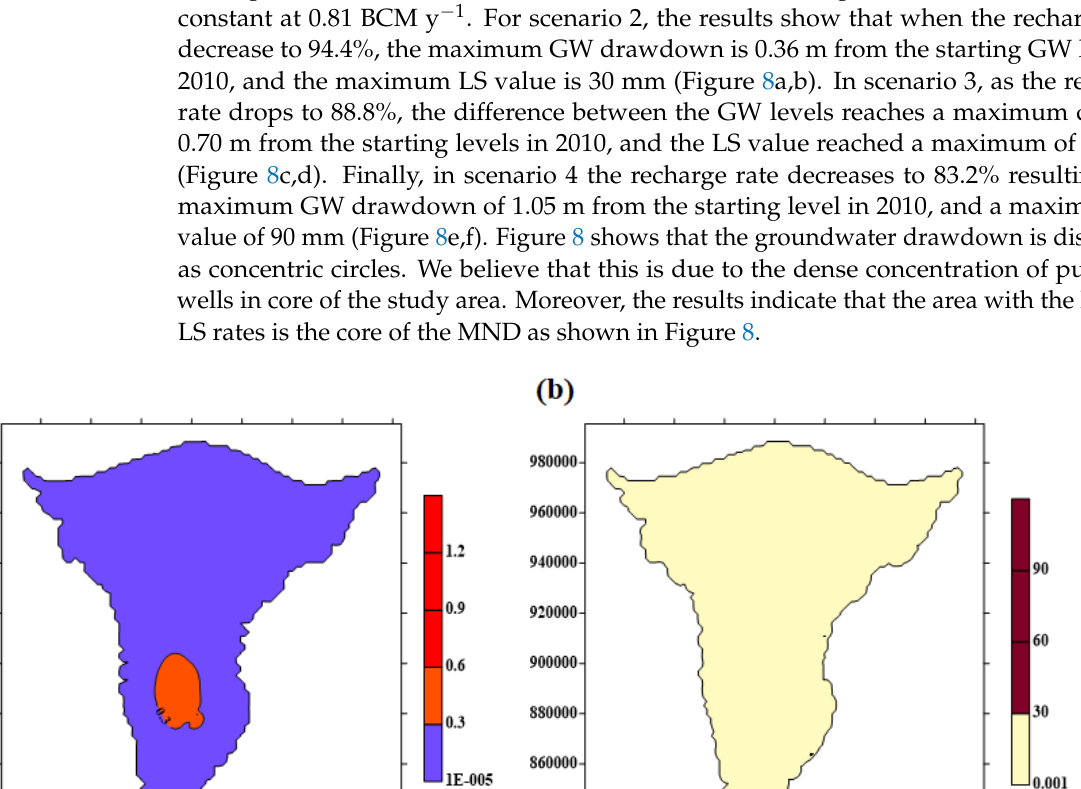
Figure 7. Model calibration results ( a ) land subsidence map in (mm), ( b ) cross section (Y-Y) of LS .